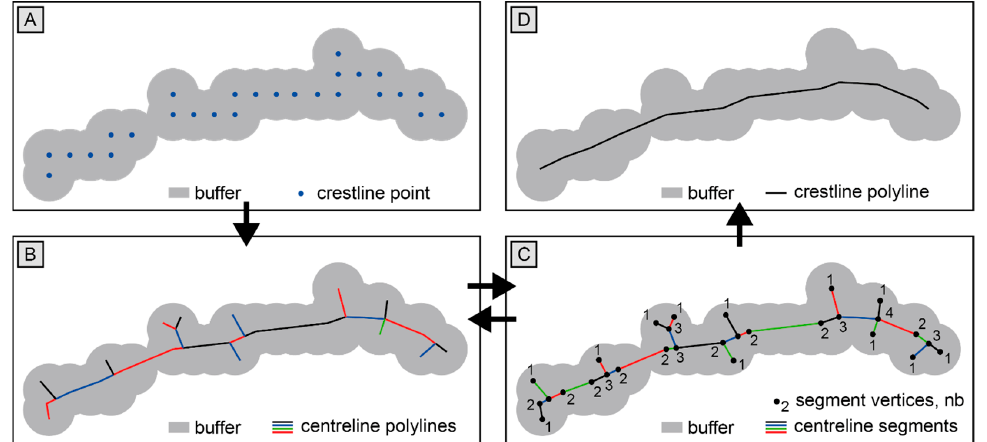
Figure 5. Generation of crestline polylines. A polygon, obtained from the generation of a buffer around crestline points ( A ), is used as input to generate a centreline, which includes several branches ( B ). Each polyline segment corresponds to a unique line ( B ). Therefore, counting the number of overlapping vertices highlights connecting nodes: intersections, bends and end points are characterised by 3, 2 and 1 vertices, respectively ( C ). Segments that are characterised by at least three overlapping vertices on one end and only one vertex on the other (i.e., branches) are then iteratively discarded to obtain a clean centreline ( D ).